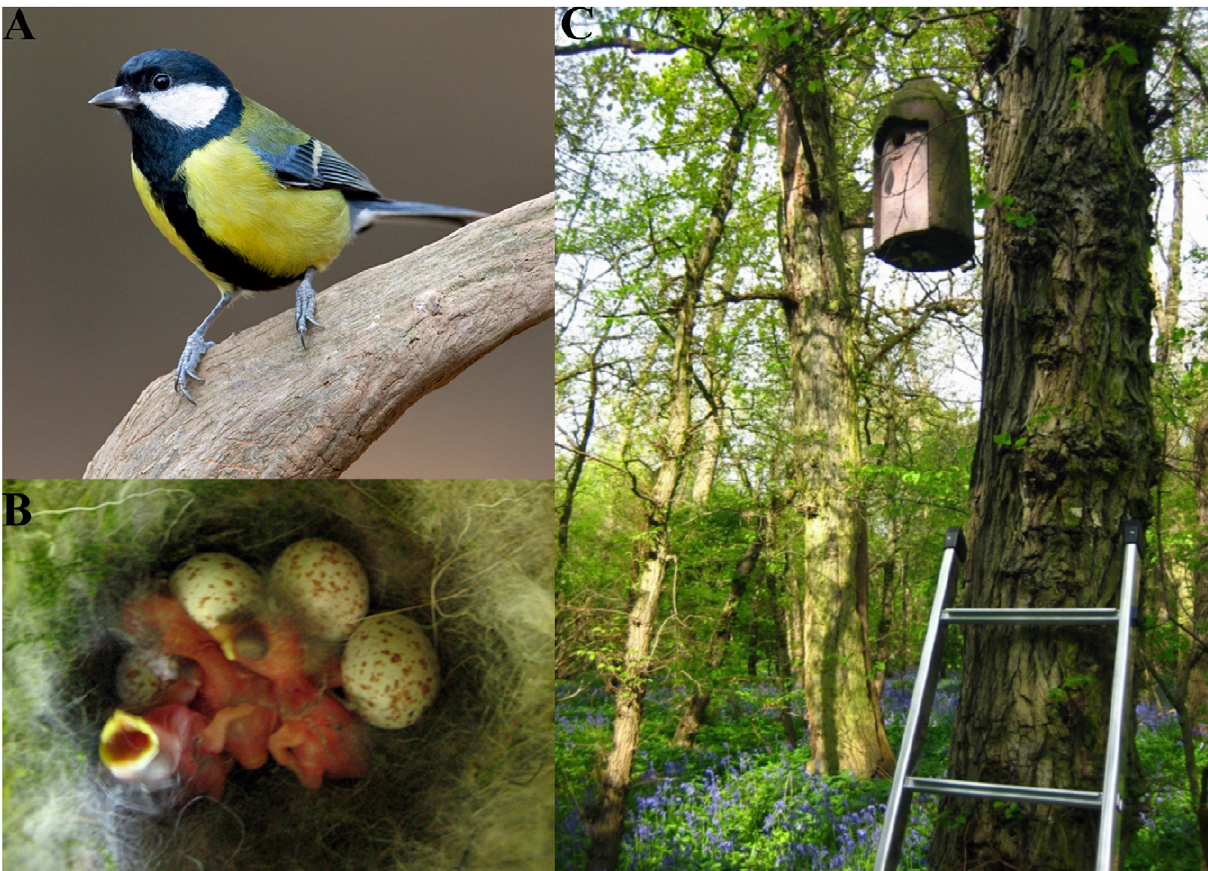
Figure 1. Madingley Wood in Cambridgeshire (UK) is a popular nesting site for great tits ( Parusmajor ). (A) A male great tit. (B) A nest (day =0) containing newly hatched chicks as well as several eggs that have not yet hatched . (C) A woodcrete nestbox in Madingley Wood. Photo credits: D. Kjaer (A) and M. C. Stoddard (B-C).